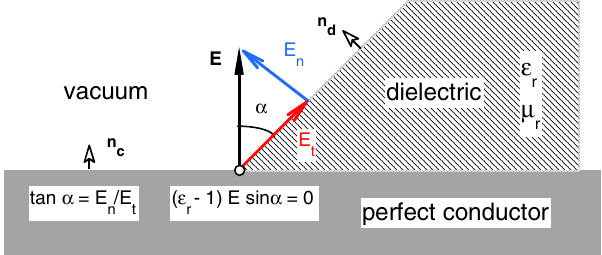
; on the x -amplitude to the x